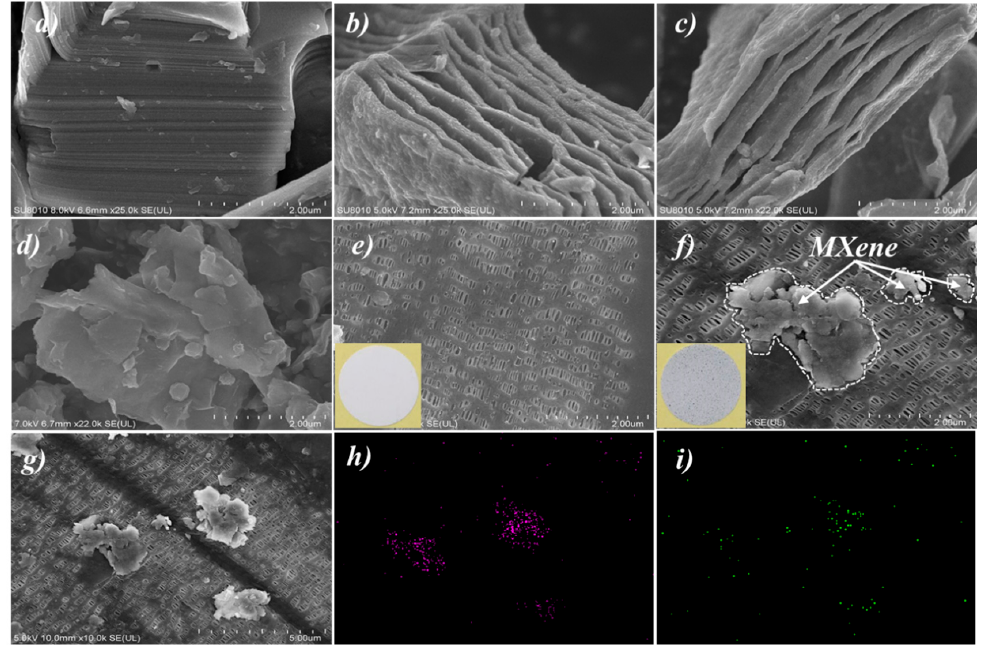
Figure 2. SEM images of ( a ) Ti 3 AlC 2 , ( b – d ) MXene, ( e ) PP, ( f , g ) MXene/PP separator, and EDS analyses of ( h ) Ti and ( i ) O elements. of ( h ) Ti and ( i ) O